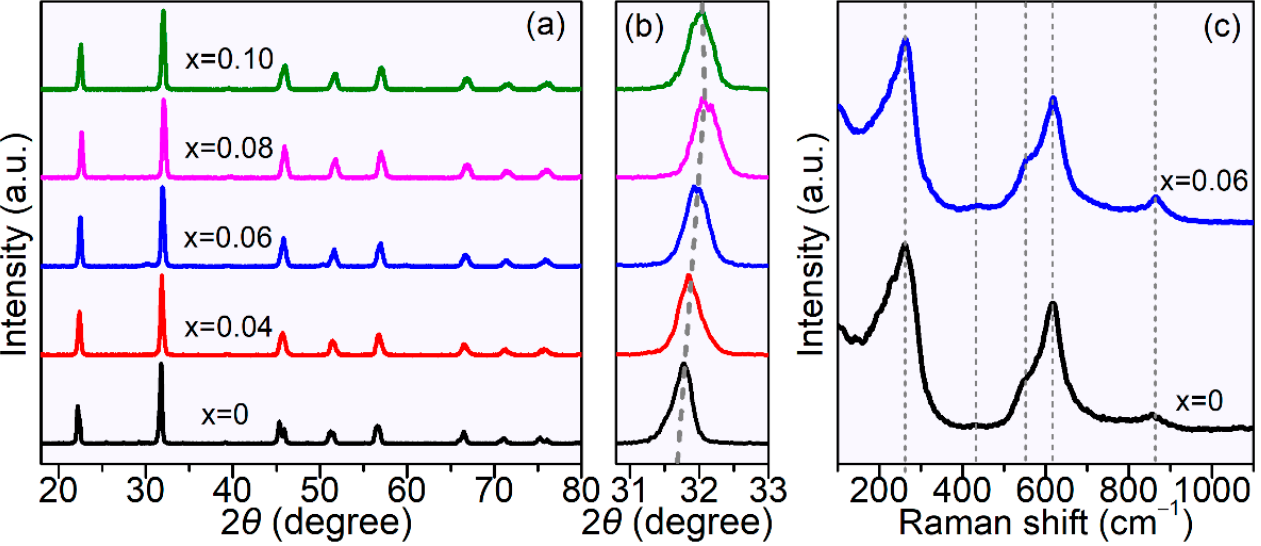
Figure 1. Composition-dependent ( a ) XRD patterns and ( b ) expanded patterns of KNNS x -BNN ceramics. ( c ) Raman spectra for KNNS x -BNN ceramics with x = 0 and x = 0.06.